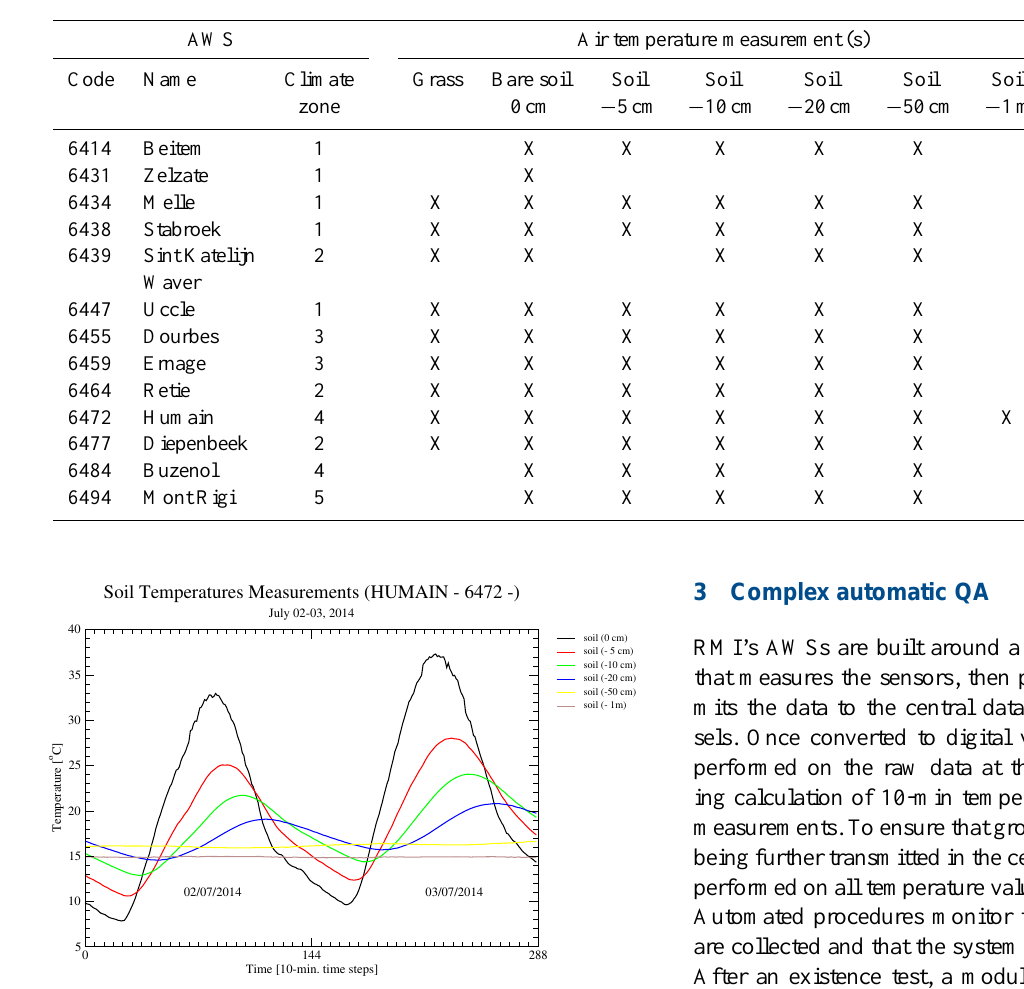
Table 1. List of the 13 RMI’s Automatic Weather Stations performing at least one soil temperature record and the associated measurements.